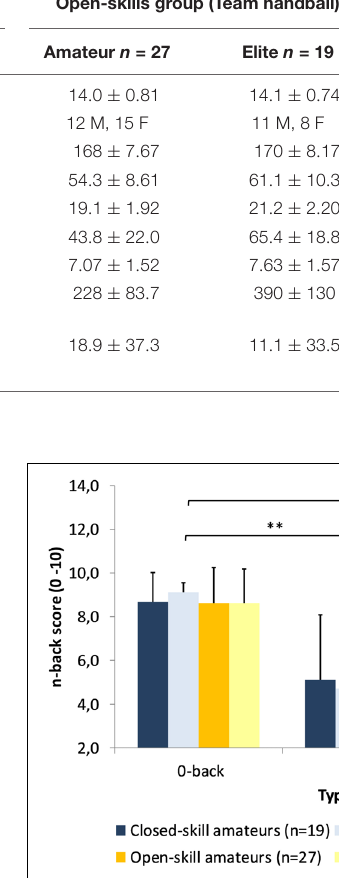
TABLE 1 | Group means ( ± SD) of the characteristics of the open skills sport players, and the closed skills sport athletes according to their expertise level. Closed-skills group (Track-and-Field)